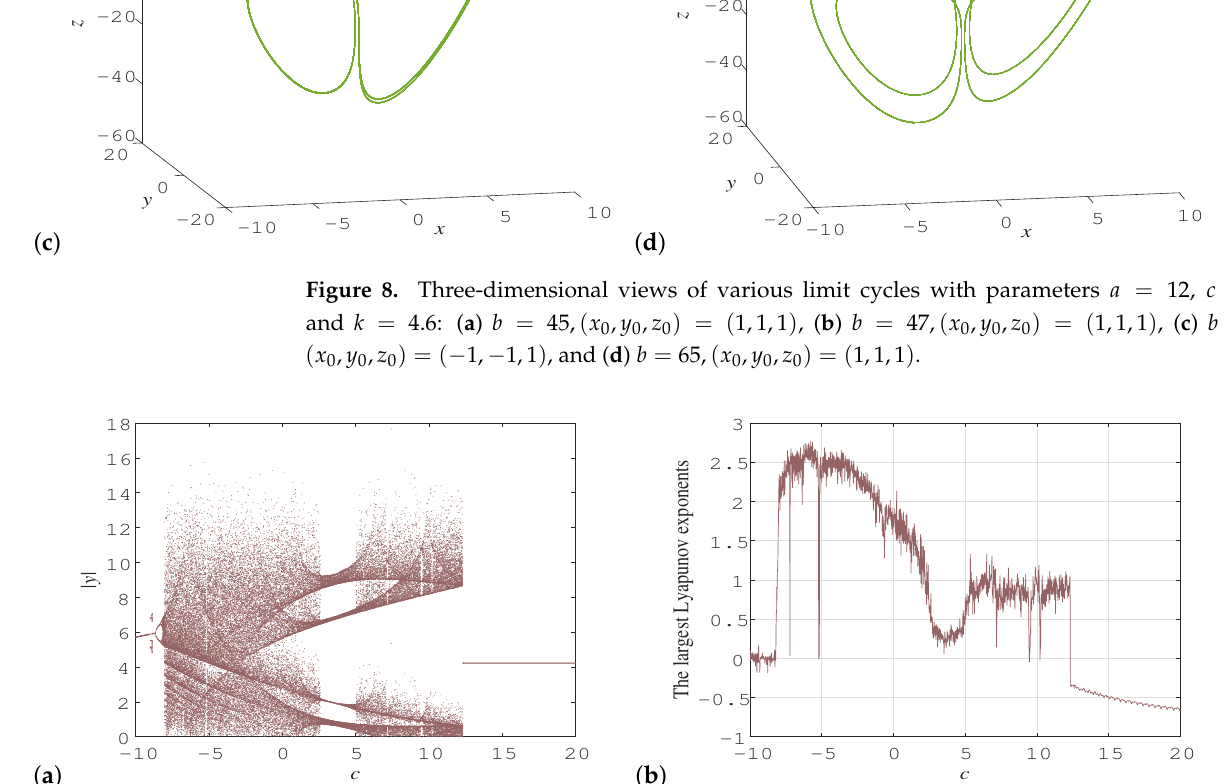
Figure 9. ( a ) Bifurcation diagram of | y | with c as the varied parameter and ( b ) the largest Lyapunov exponent spectrum, where a = 12, b = 100, and k =